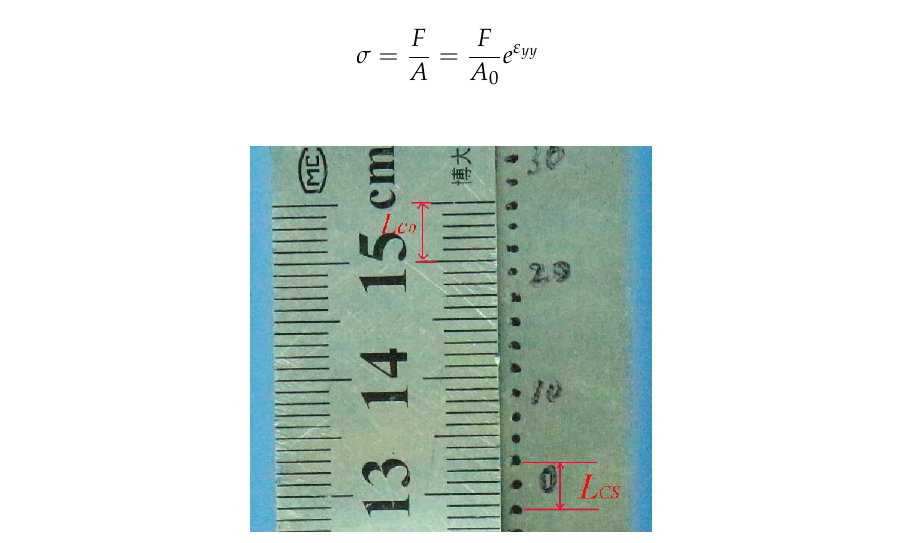
Figure 4. Diagrammatic sketch of measured range on the specimen.